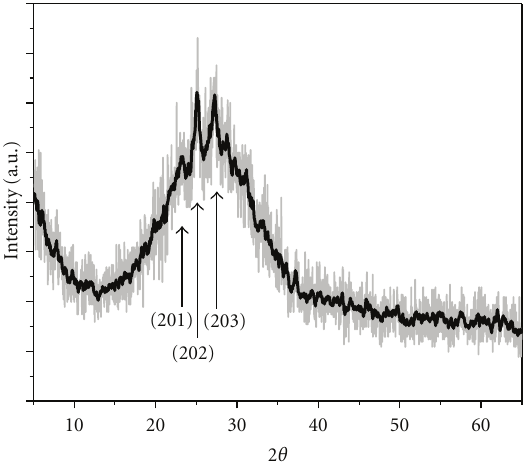
Figure 2: XRD spectra of 3,4,9,10-perylene-tetracarboxylicacid- diimide, PTCDI, as-deposited thin.